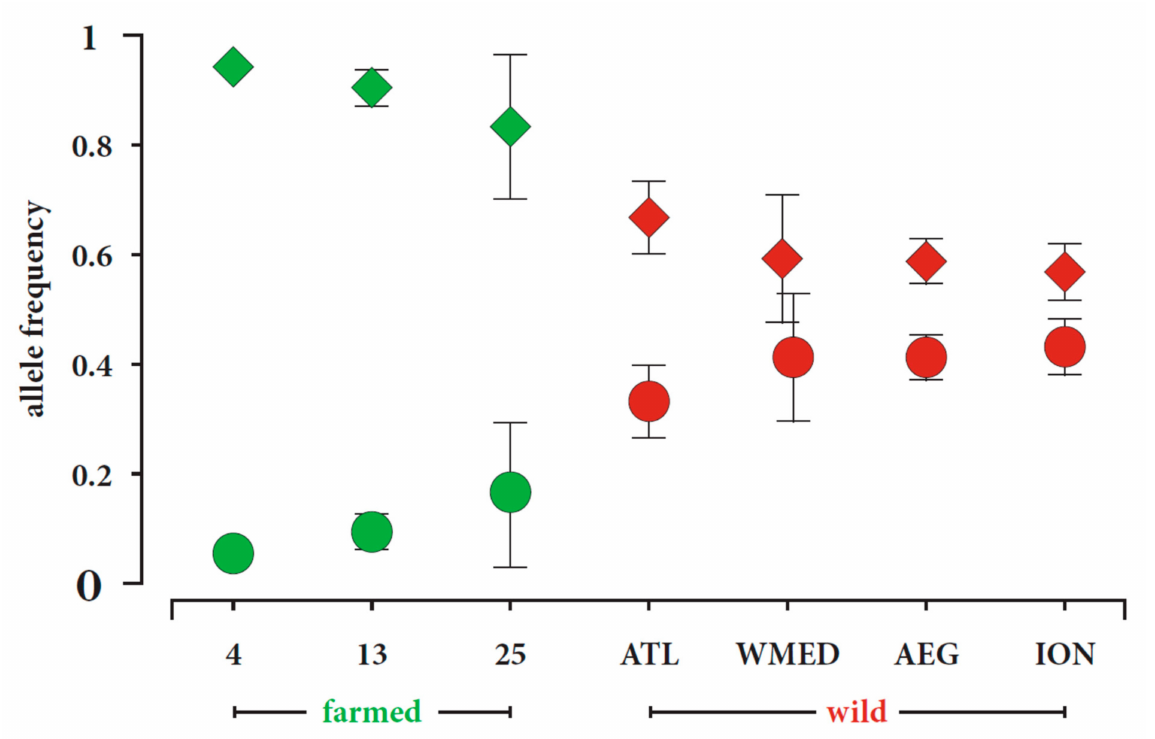
Figure 6. Plot of the allele frequencies of the SNP_901_49 at the studied clusters in which a marked change in frequencies has been observed between farmed (in green) and wild (in red) clusters of gilthead seabream populations. Error bars denote standard deviations, whereas circles and diamonds represent the two different alleles. The information of which populations are grouped in each cluster id can be found in Table